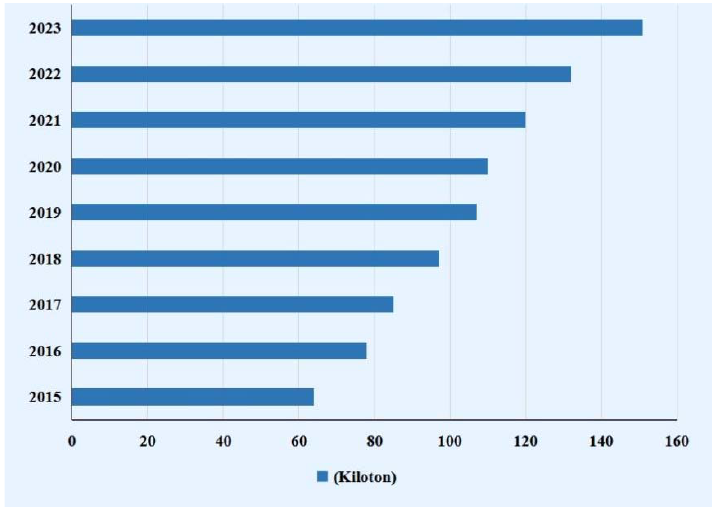
Figure 1. Global demand for CFs.